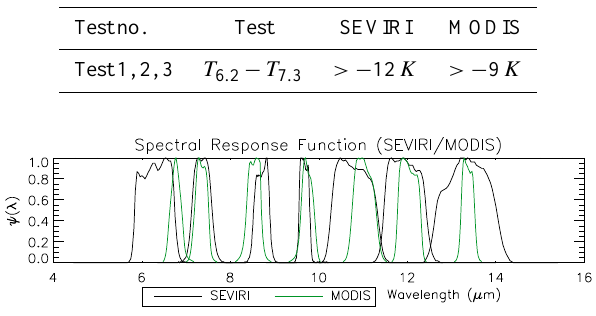
Fig. 7. Spectral response functions ψ of the thermal channels of SEVIRI and MODIS as a function of wavelength λ